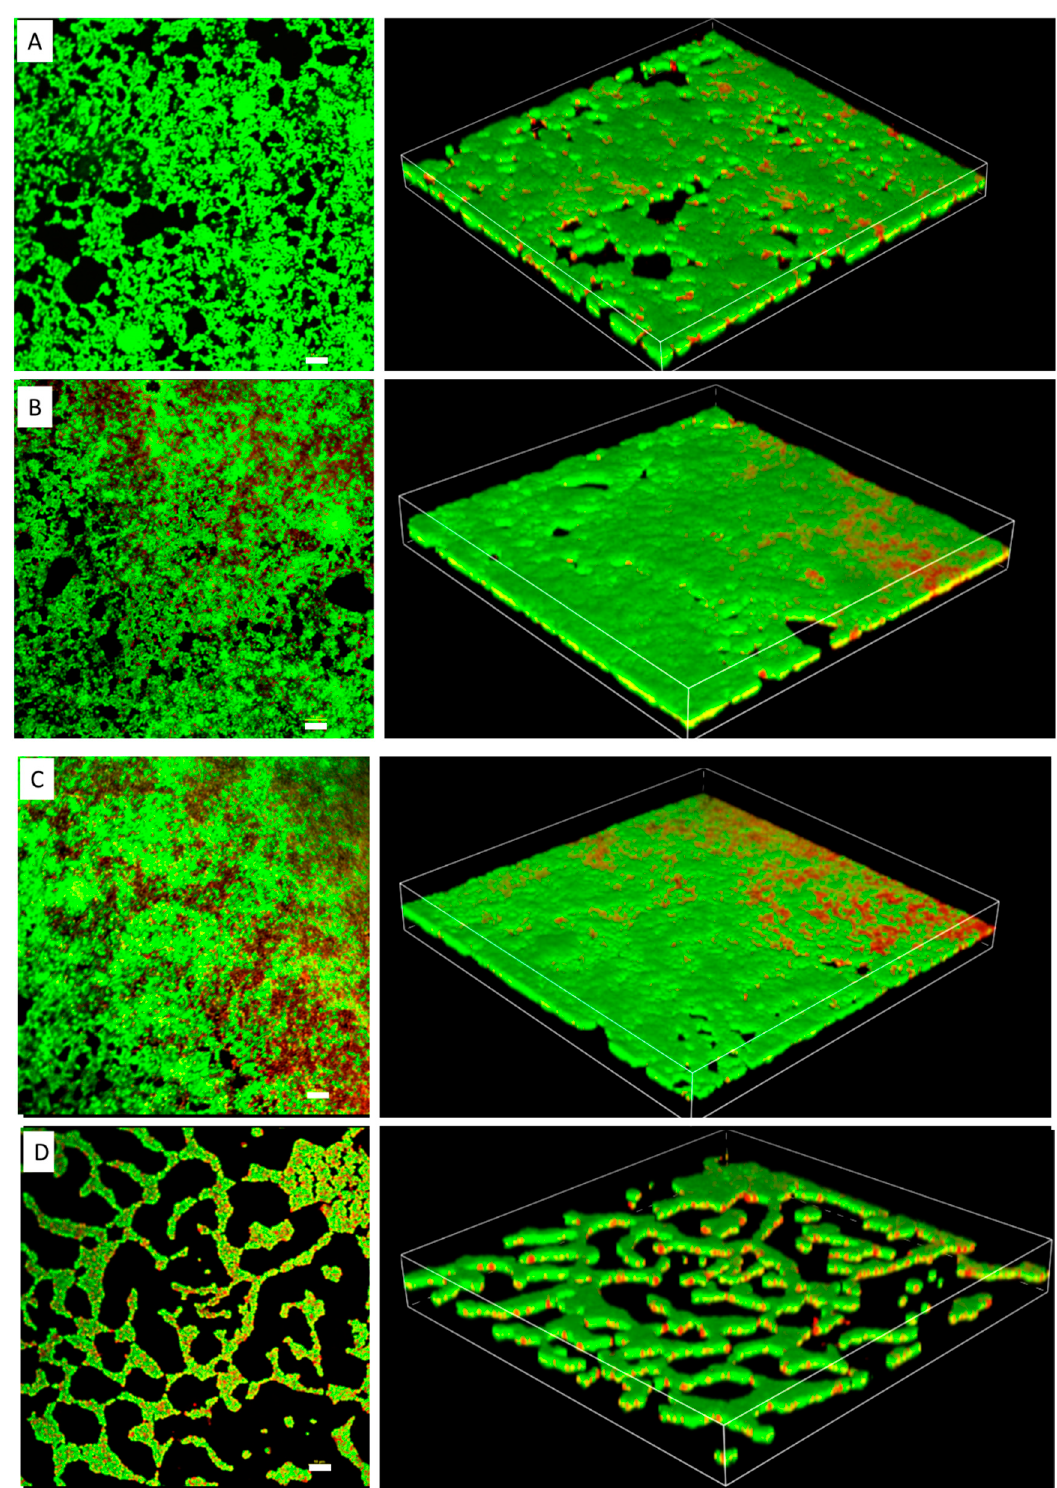
Figure 2. Confocal laser scanning microscopy images of S. epidermidis strain RP62A biofilms. The scale bar in all the images corresponds to 10 µm. Left panels show an orthogonal view of the top biofilm layer and right panels show 3D images. ( A ): Control, ( B ): 1/8 MIC, ( C ): 1/4 MIC, ( D ): 1/2 MIC.